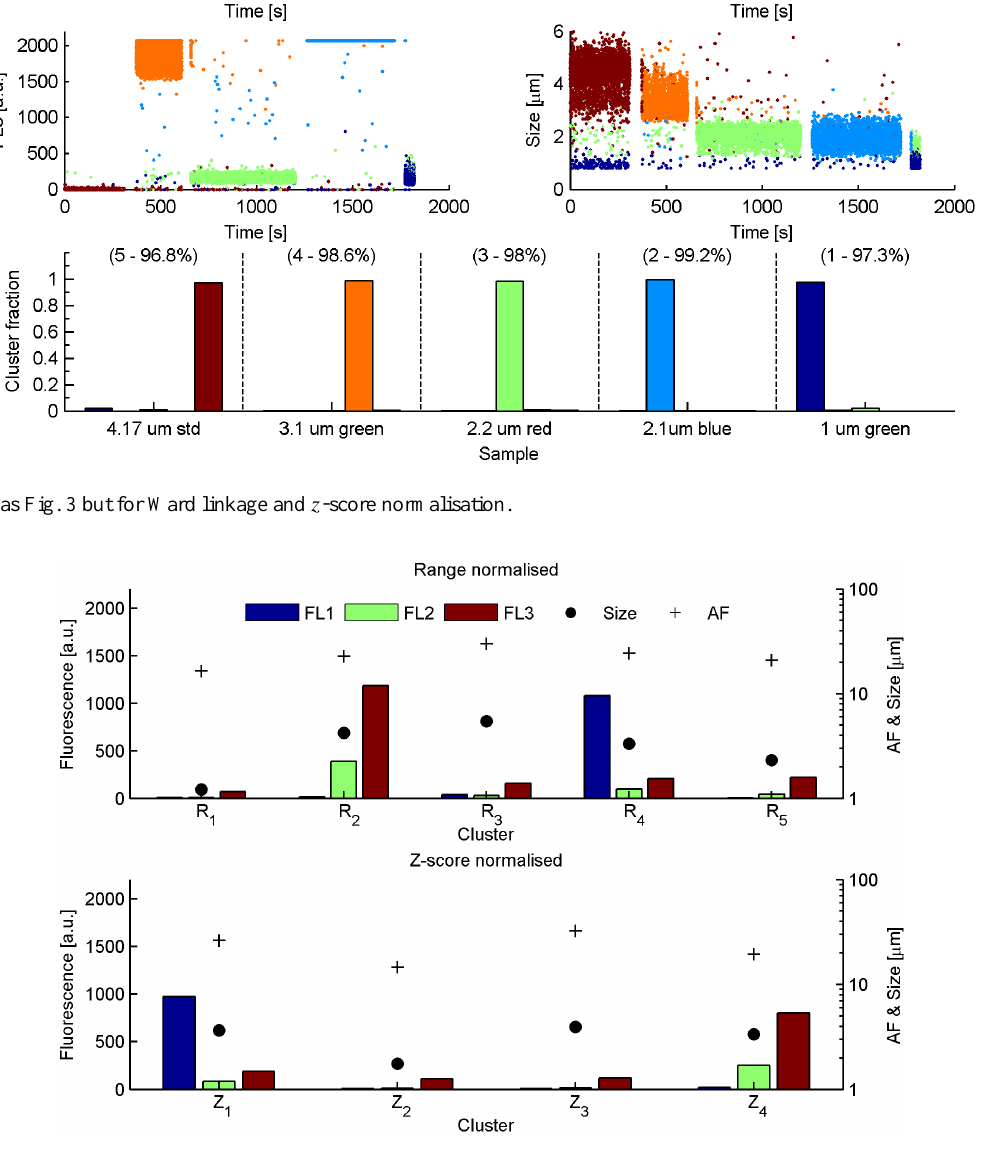
Figure 5. Same as Fig. 2 but for BEACHON-RoMBAS ambient